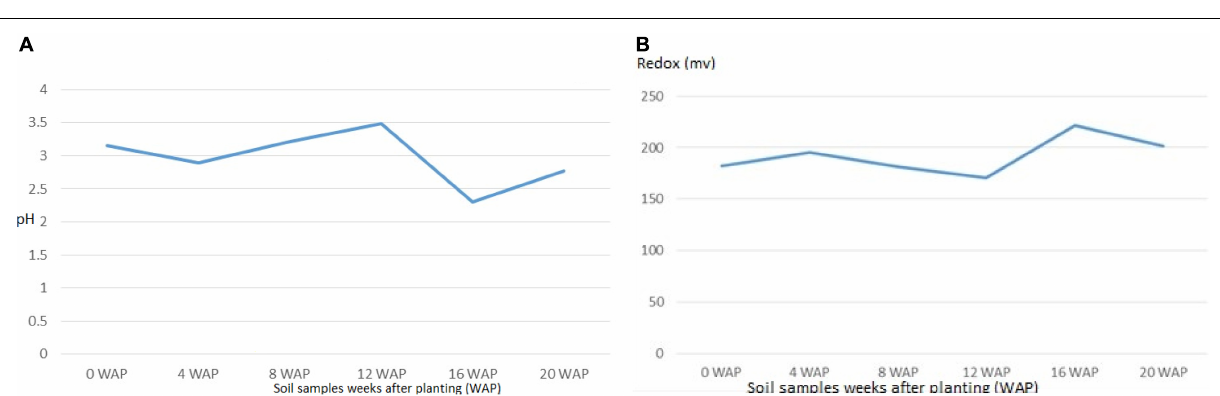
FIGURE 5 | (A) Average pH values of soil samples from original soil to the time harvest. The highest pH was at 12 WAP, while the least was at 16 WAP. (B) Average Redox value for soil samples at the different growth stages from original soil to the time harvest. The highest value was at 16 WAP, while the lowest was at 12 WAP. The line graph for redox and pH is inversely